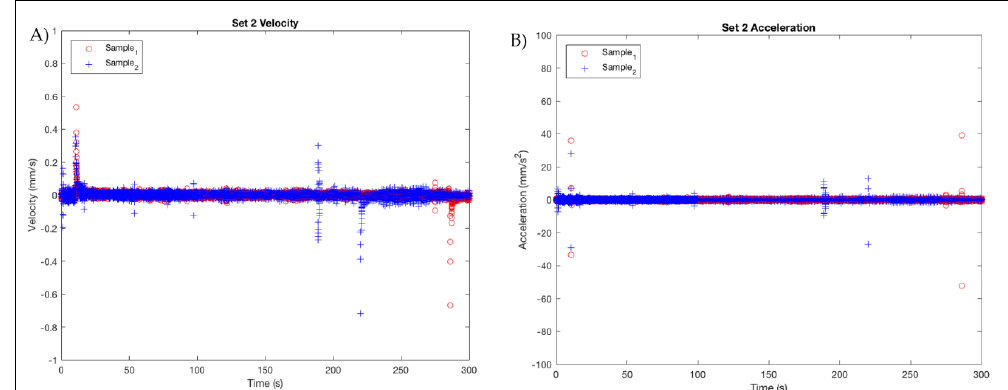
Figure 6. Set 2 ( A ) Velocity and ( B ) Acceleration.